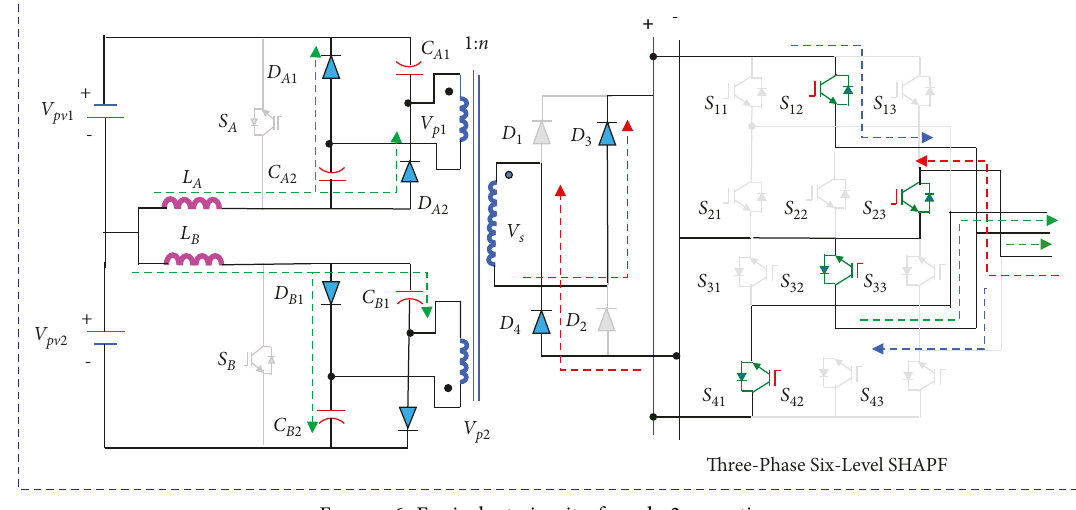
Figure 6: Equivalent circuit of mode 2 operation.